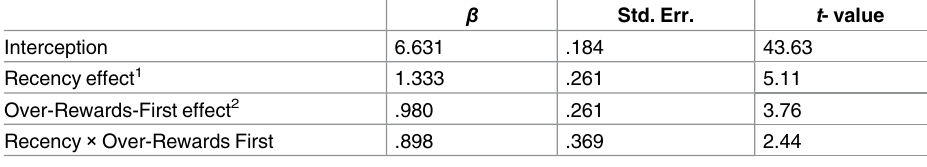
Table 2. Estimated Fixed Effects of the Manipulation and